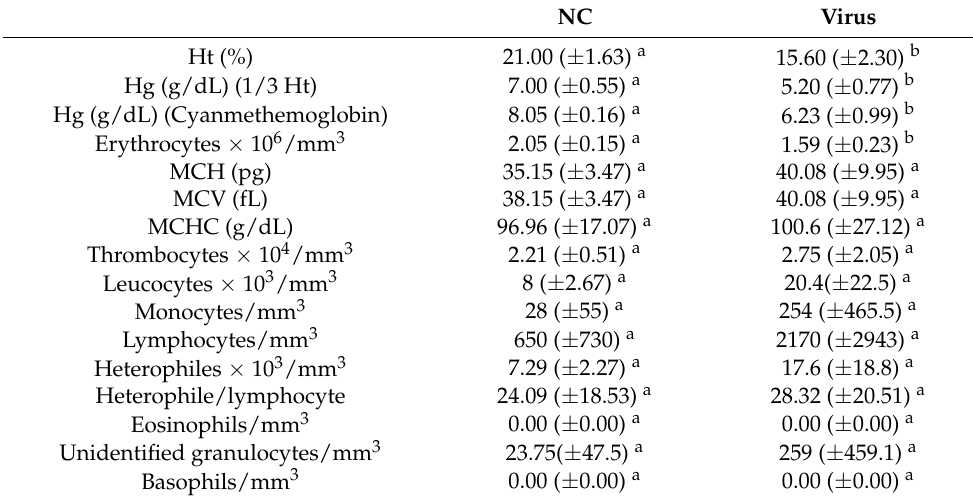
Table 1. Blood cell counts in CE treated with Gammacoronavirus inoculated at 10 EID.